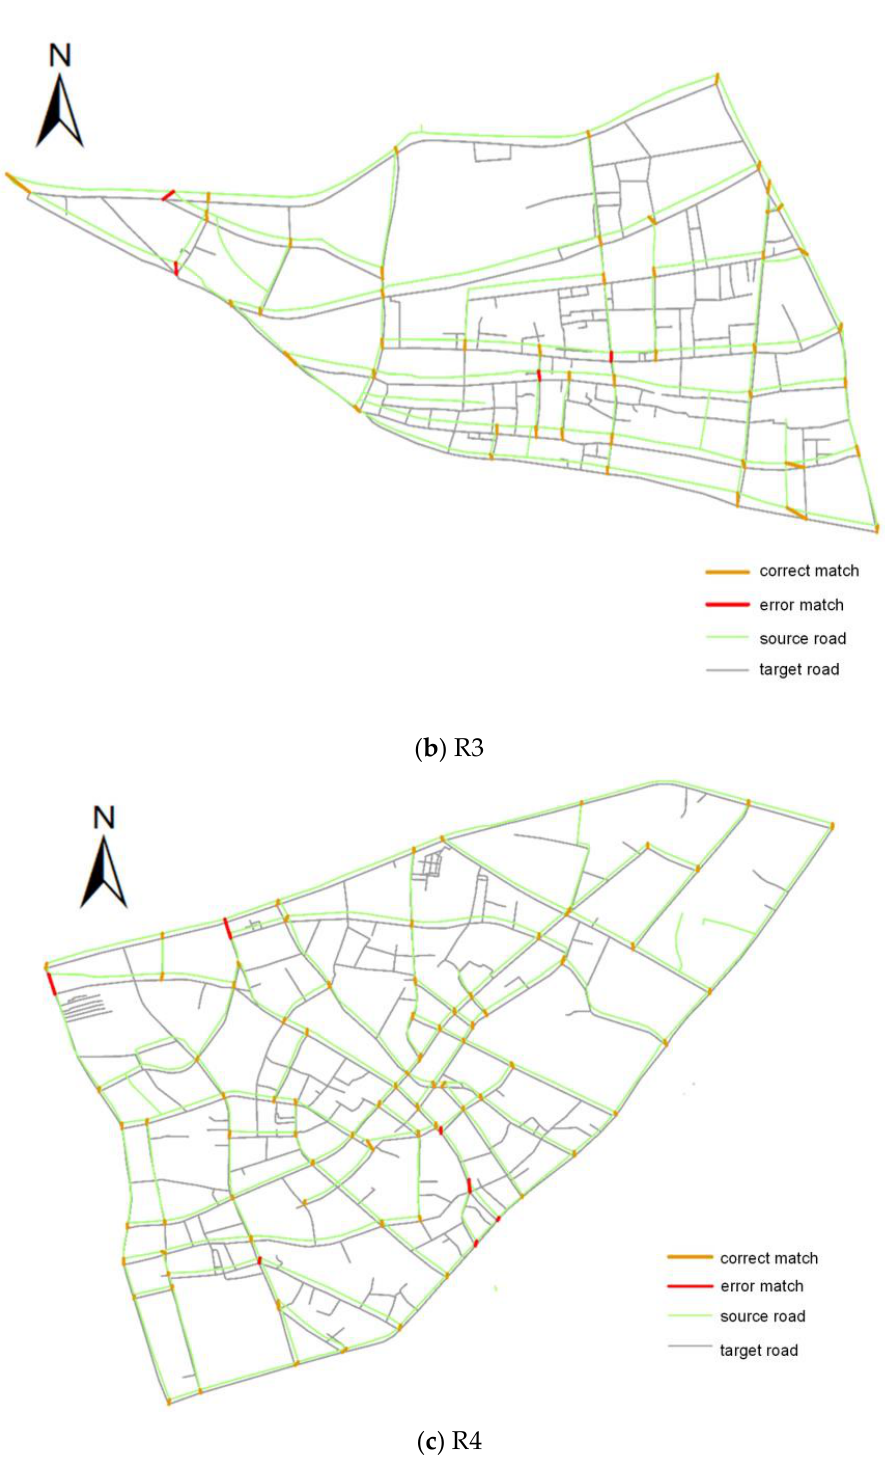
Figure A2. Matching results of DTRM for the four subregions of Area 2 (R2, R3, R4, and R5). ( a ) Matching result of R2, ( b ) matching result of R3, ( c ) matching result of R4, and ( d ) matching result of